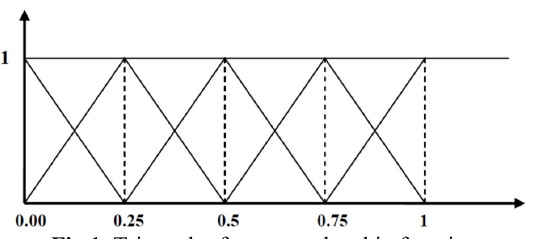
Fig 1 . Triangular fuzzy membership functions